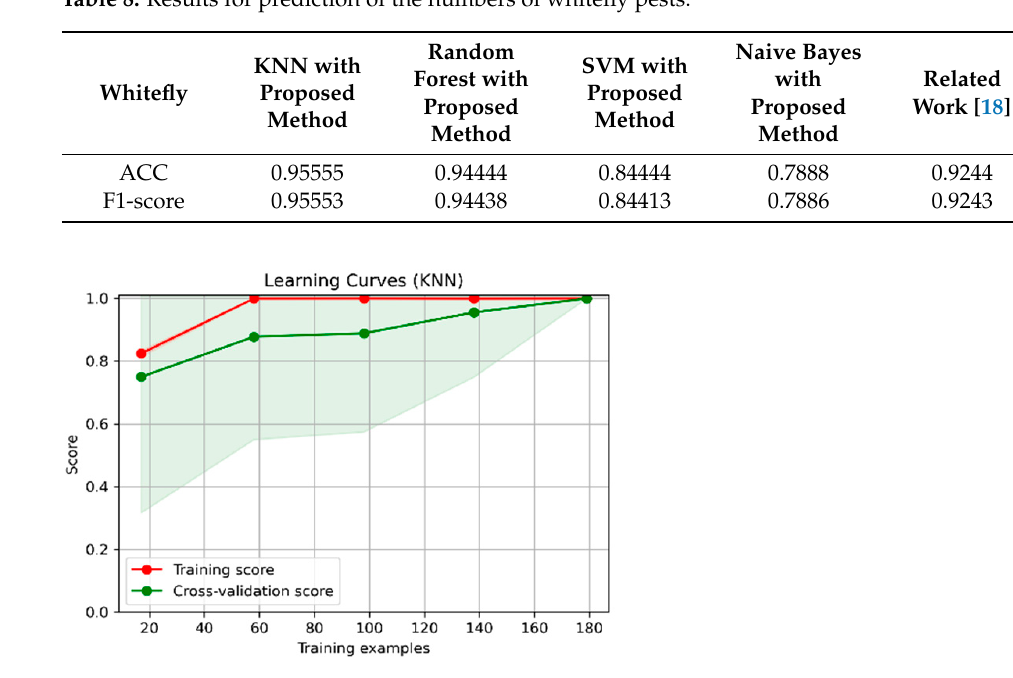
Figure 11. Learning curve for the KNN model of whitefly pests.